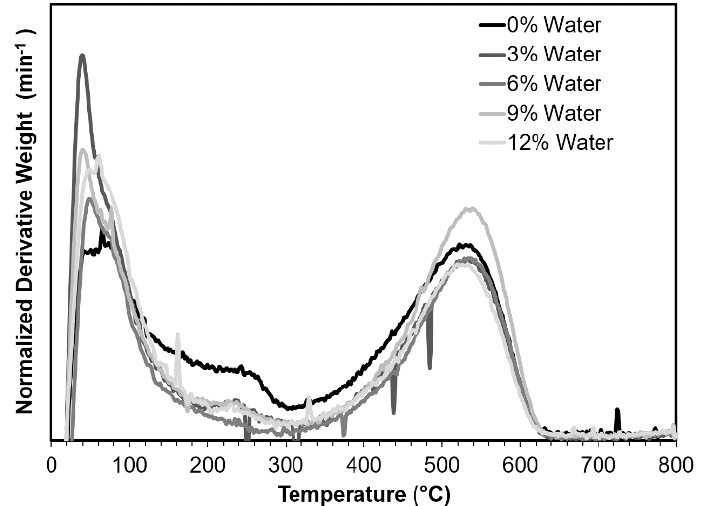
Figure 3. Normalized derivative weight curves with respect to temperature in 20 mL/min of air at a heating rate of 10 °C/min for all spent ZSM-5 catalysts.